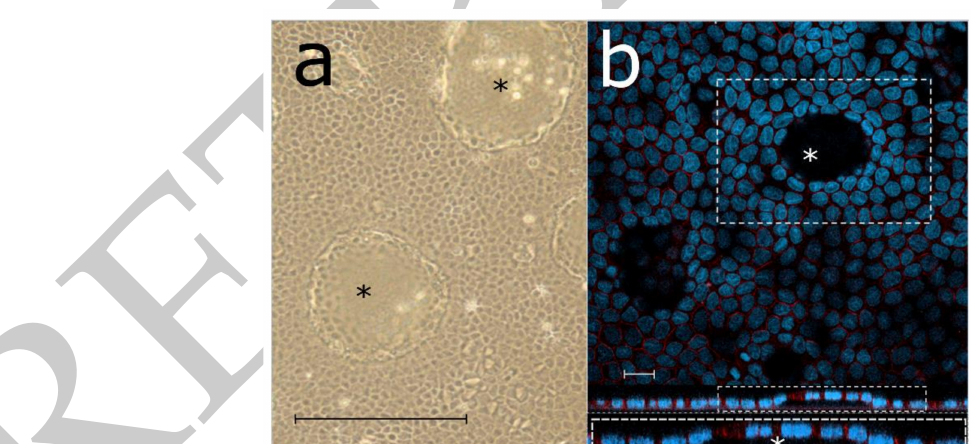
Figure 4. As evidence for cellular polarity and presence of tight-junctions, increased number of fluid-filled domes (*) were formed in LEPI cell cultures after 7 days of culturing. ( a ) Bright-field image of LEPI cells on a culture dish. Scale bar 500 µ m ( b ) Confocal microscope image of immunofluorescence stained LEPI cells on ibidi slide, scale bar 20 µ m. Lateral plasma membranes counterstained with multi-drug resistance associated protein 1 (MRP1, red) and DAPI stained cell nuclei (blue). Inset of boxed area displaying X-Z section view (apical / basal sides) of the fluid-filled dome (*) in the cell monolayer. The domes are seen as holes in the images that display the top view of the culture. The cells at that z-level are located above the section that is in focus